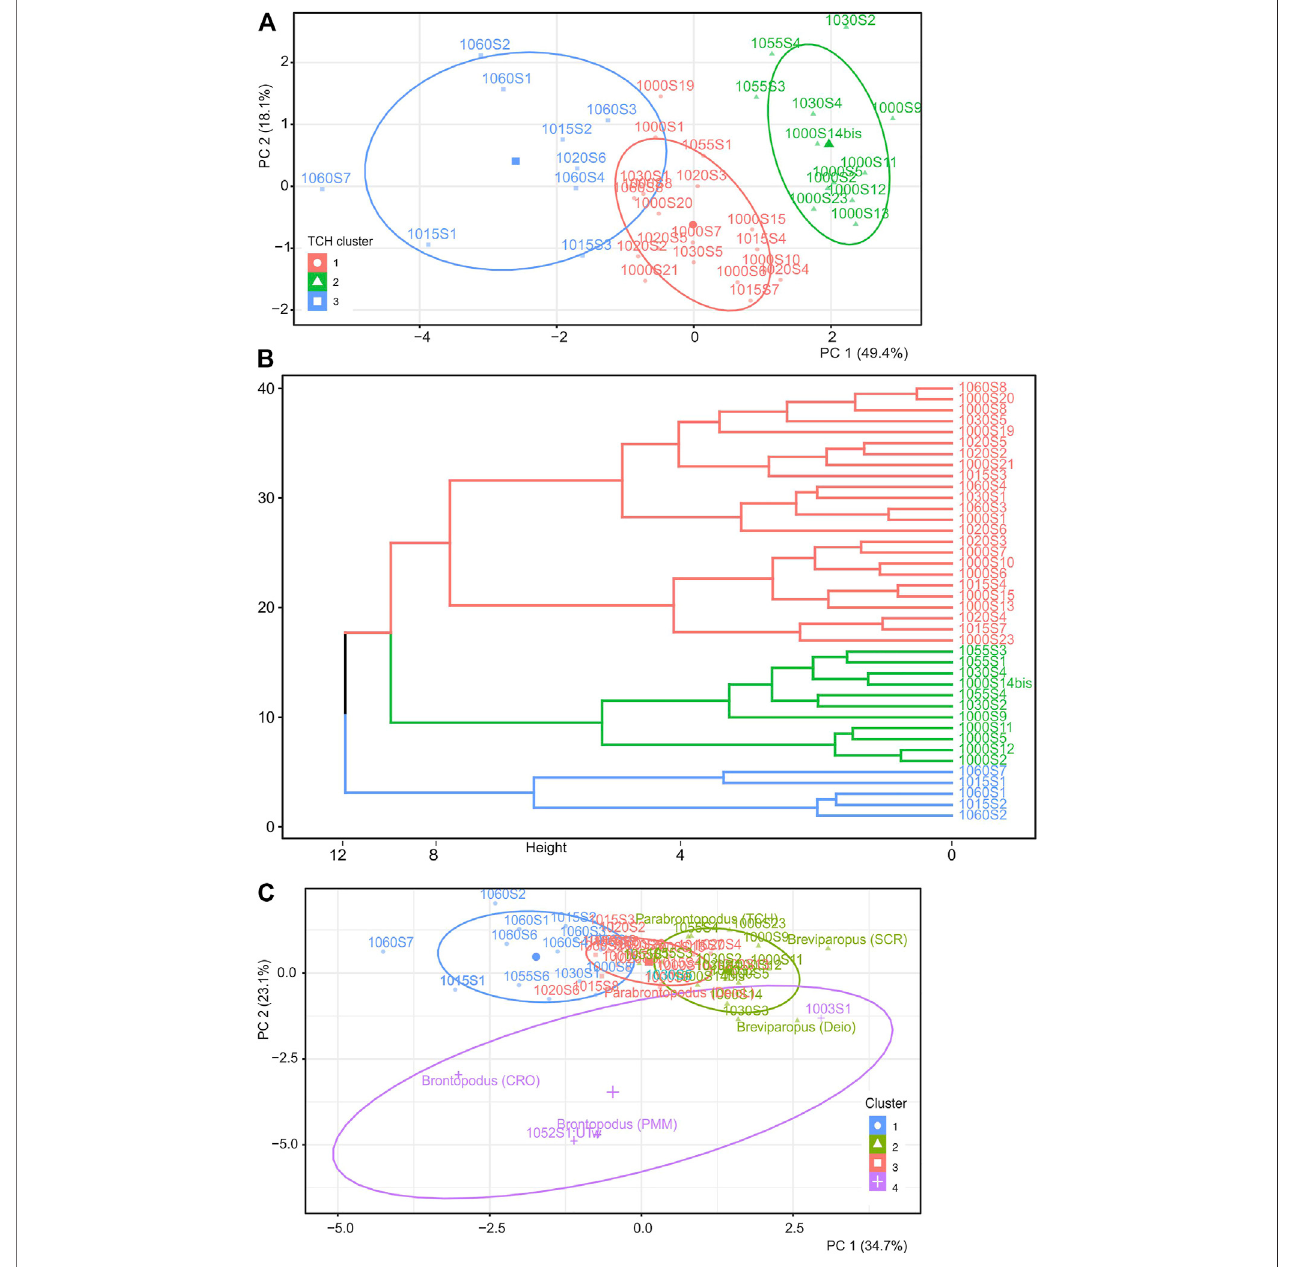
FIGURE 5 | (A) HK-Means cluster analysis plot of all TCH trackway data using k = 3 via the Silhouette and Elbow Method. (B) Dendrogram of HK-means. (C) HK- means cluster analysis plot of TCH data and ichnogenera from Marty et al. (2010) with k = 4.